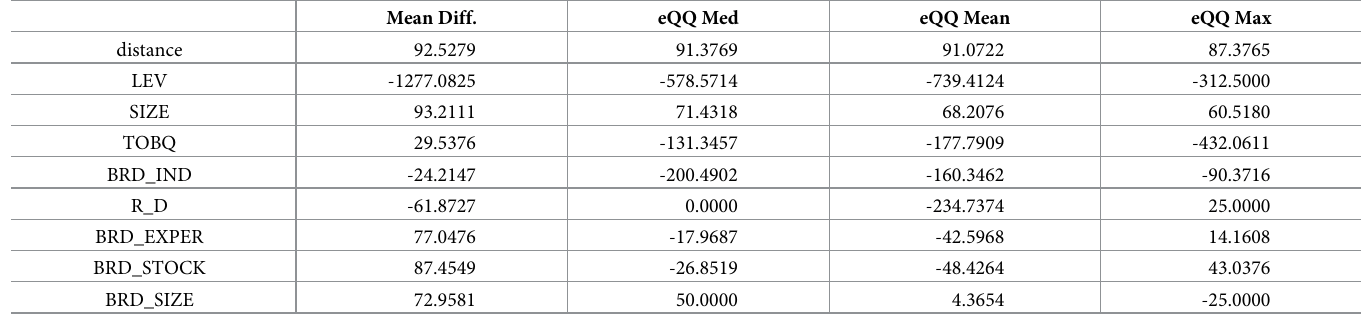
Table 9. Percent balance improvement.